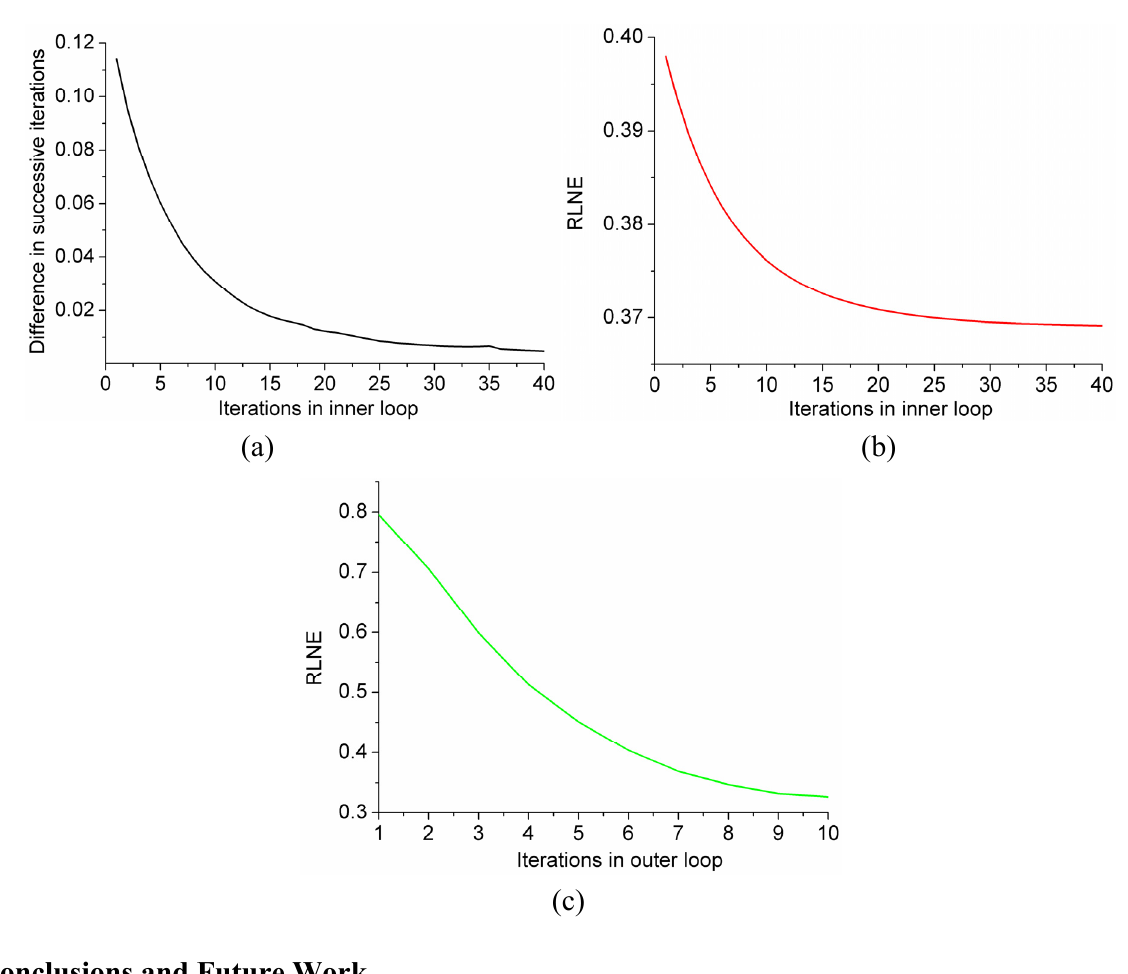
Figure 12. Numerical performance of PSOCA. ( a ) The ℓ reconstructed spectra in the current and previous iteration when β = 2 12 in inner loop; ( b ) the reconstruction error RLNE of the reconstructed spectra when β = 2 12 in inner loop; and ( c ) the reconstruction error RLNE versus the iterations in outer loop in